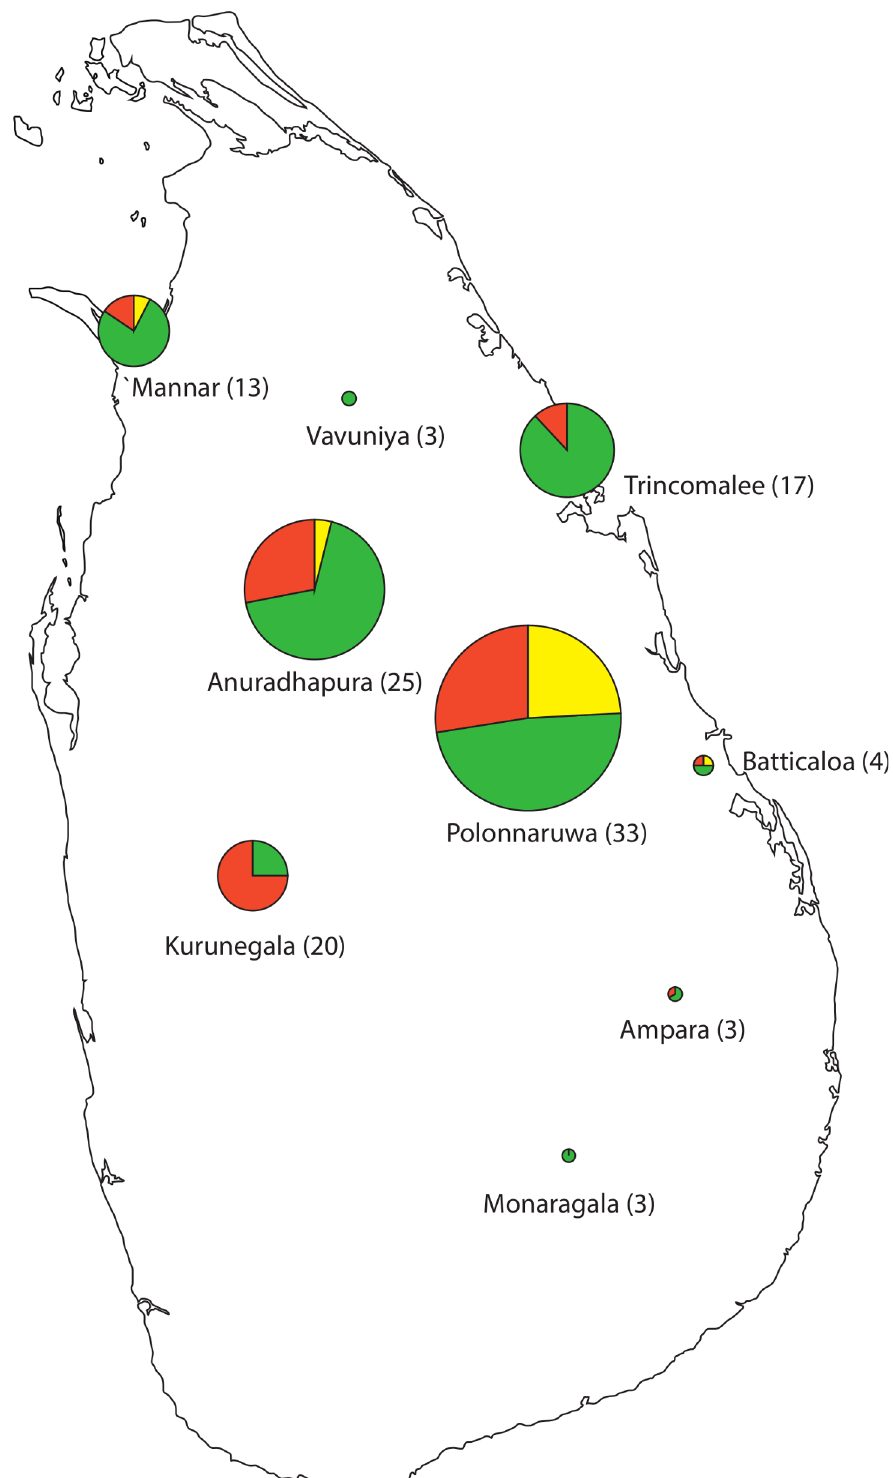
Fig 3. Genetic diversity of the Plasmodium vivax mdr1 gene in P . vivax samples collected at 9 malaria endemic districts of Sri Lanka. Three different genotypes were detected in the samples from Sri Lanka named MYF(yellow), MYL(green) and MFL(red). MYF (single mutant, T958M), MYL (double mutant,